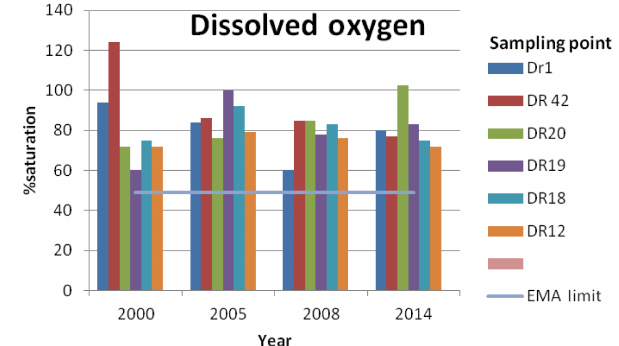
Figure 10. pH variations along sampling